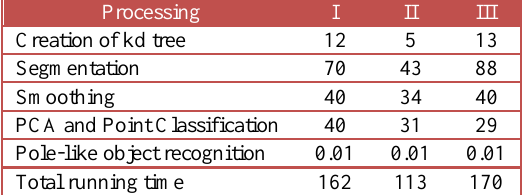
Processing Creation of kd tree